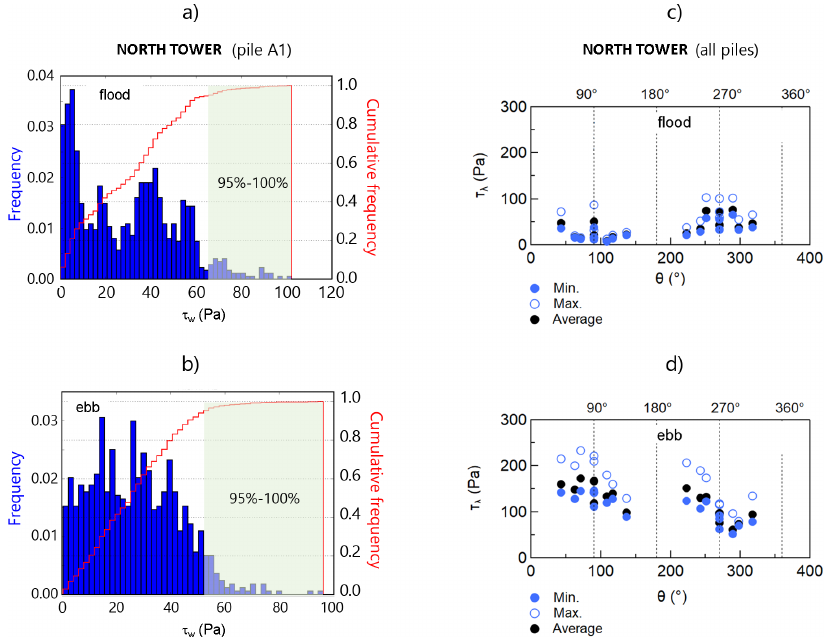
Figure 9. Frequency distribution of τ w ( t ) for pile A1, obtained for t > t ∗ (upper left pier in Figure 2a) of the NT for ( a ) the flood-tide ( b ) and the ebb-tide scenarios. The cumulative frequency curve (in red) is also included. Distribution of τ λ versus the central angle θ (Figure 2c) for ( c ) the flood-tide ( d ) and the ebb-tide scenarios. Minimum, maximum and the average of this parameter are shown for reference. Figures adapted from